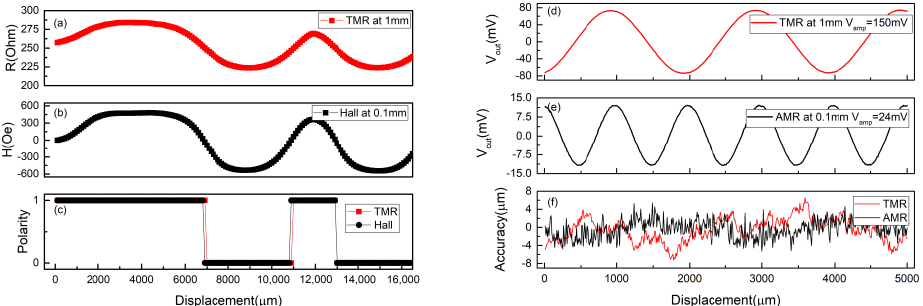
Figure 7. The measurement results of the ABS line measured by ( a ) TMR sensor and ( b ) commercial Hall sensor. ( c ) The corresponding polarities of the sensors. The measurement results of the INC line measured by ( d ) TMR sensor and ( e ) commercial AMR sensor. ( f ) The accuracy comparison of the sensors. Only single bridge outputs for INC are shown here.